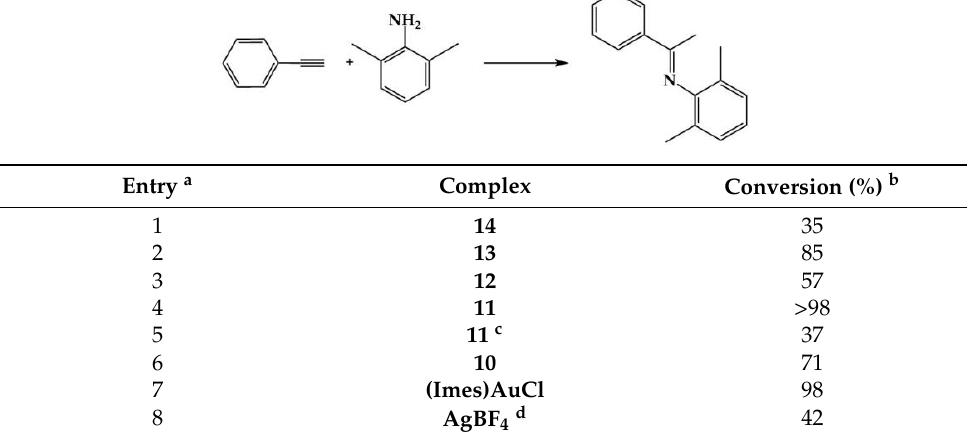
Table 1. Catalyst screening for the hydroamination of phenylacetylene with 2,6-dimethylaniline.